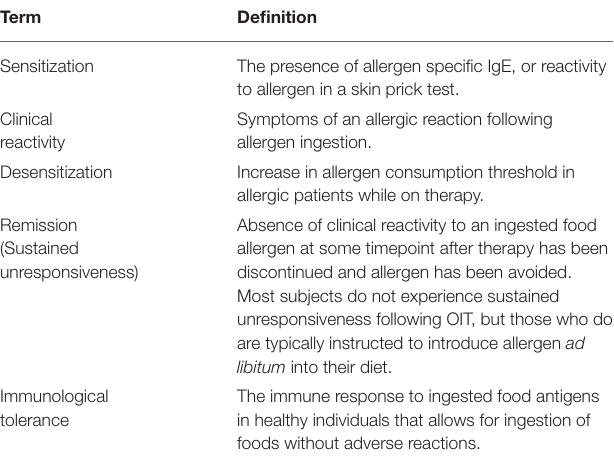
TABLE 1 | Clinical terminology